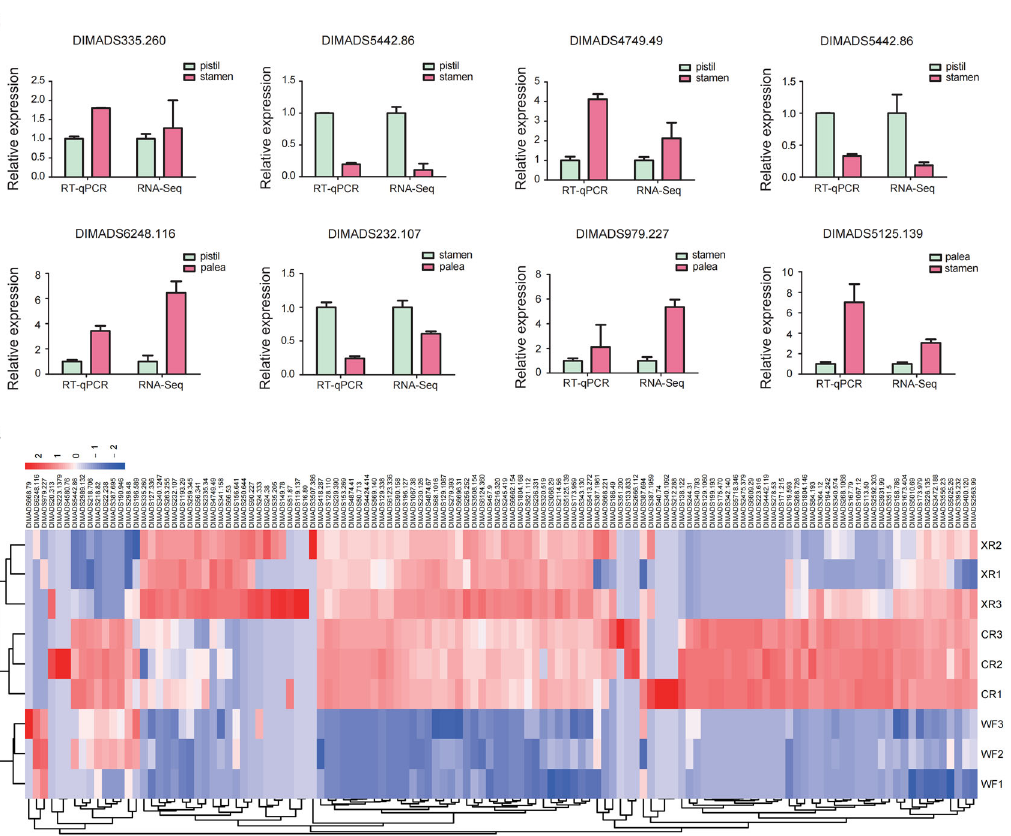
Figure 5. Expression of MIKCc-type MADS-box gene in flower organs. ( A ) MADS-box genes obtained by RT-qPCR analysis. ( B ) Heatmap of the expression of 170 MIKCc-type MADS-box genes in the flower organ.